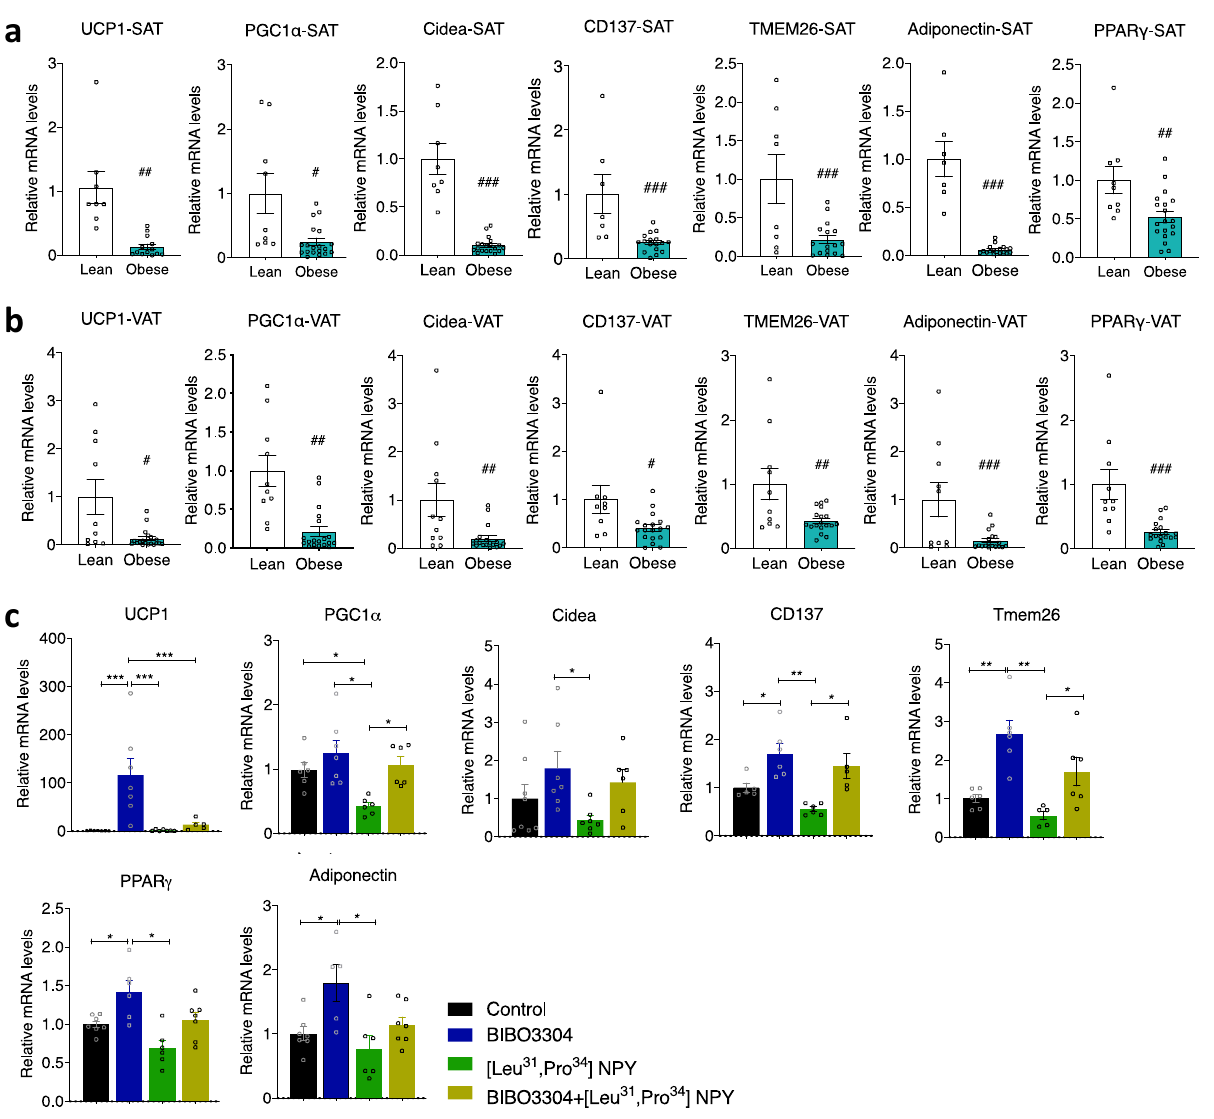
Fig. 9 Peripheral Y1R antagonism activates thermogenesis in human adipocytes. a mRNA levels of thermogenic and lipogenic markers in subcutaneous white adipose tissue (SAT) of lean and obese subjects. Data are mean ± s.e.m, lean n = 9 (white bar), obese n = 18 (cyan bar), # p < 0.05, ## p < 0.01, ### p < 0.001 by two-tailed t test. b , mRNA levels of thermogenic and lipogenic markers in visceral adipose tissue (VAT) of lean and obese subjects. Data are mean ± s.e.m, lean n = 10 (white bar), obese n = 19 (cyan bar). # p < 0.05, ## p < 0.01, ### p < 0.001 by two-tailed t test . c mRNA levels of thermogenic and lipogenic markers in stromal vascular fraction (SVF) isolated from obese subjects cultured and differentiated ex vivo and treated with Y1R-speci fi c agonist [Leu31,Pro34] NPY and/or antagonist BIBO3304 for 48 h. Data are mean ± s.e.m, n = 5 – 8 per group (control: black; BIBO3304: blue; [Leu31,Pro34] NPY: green; BIBO3304 + [Leu31,Pro34] NPY: mustard). * p < 0.05, ** p < 0.01, *** p < 0.001, one-way ANOVA with Tukey ’ s multiple comparisons test. Source data are provided as a Source Data fi